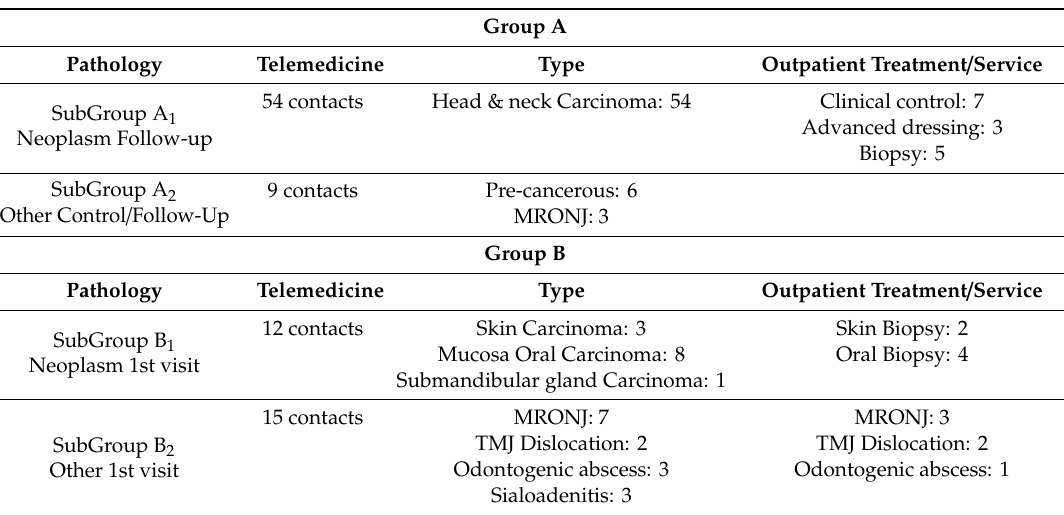
Table 4. Results of the A and B